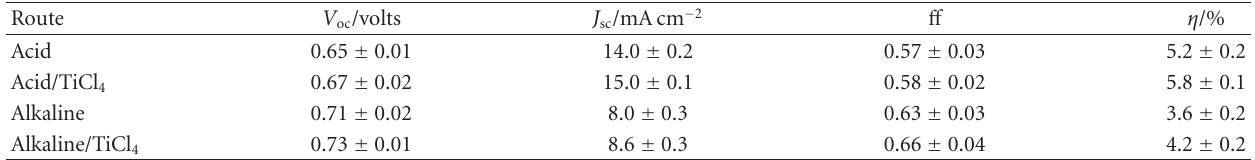
Figure 2: O-1s (a) and Ru-3d 5 / 2 (b) peaks of N3-sensitized TiO 2 films prepared by acid (—) or alkaline (---) routes. Table 2: Photoelectrochemical parameters determined for DSCs using TiO 2 obtained by the acid or alkaline routes. (100mWcm − 2 , AM